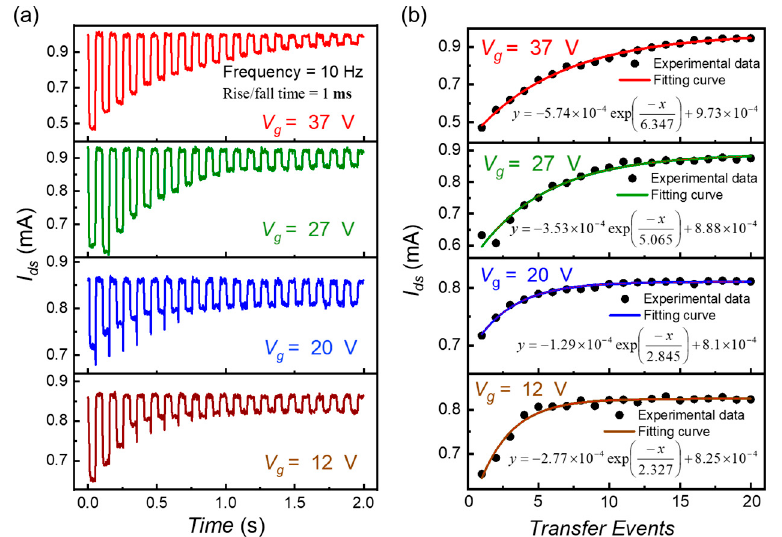
Figure 4. ( a ) For the back-and-forth charge transfer experiment for two adjacent Gr-Si CCD pixels platform, I ds is recorded when V g 1 and V g 2 phases are applied to the two graphene gates. The to and fro transfer of charges is shown for 20 cycles of two input phases. For almost all the amplitudes and switching slopes of two phases, a decaying trend in the initial E fg of the readout graphene channel is observed. This decay collectively corresponds to the in-pixel defect trappings and recombination losses in the inter-pixel region ( b ) The I ds increase with each readout, reducing the net number of charges. The fitting of the I ds values traces the losses. For four V g 1 ( 12, 20, 27, 37 ) V and 1 ms switching slopes, exponential fitting successfully highlights the transfer losses. The decaying exponential equations for each measurement situation are also mentioned.